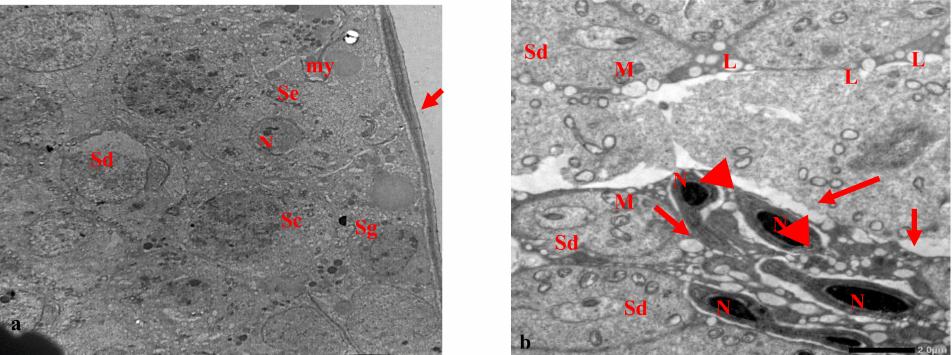
Figure 6. ( a , b ): Electron micrograph of a section of rat’s testis in the control group. ( a ) showing normal seminiferous tubule with normal spermatogenic epithelium (arrow), spermatogonia (Sg), primary spermatocytes (Sc), and spermatids (Sd). Sertoli cell (Se) appeared with the nucleus (N) and the basement membrane enclosing myoid cell (my) ( × 1000). ( b ): showing normal sperms. The sperms have flagellum (head arrow) and an elongated condensed nucleus (N) and an acrosomal cap (arrow). The spermatids appeared (Sd) with the nucleus and cytoplasm rich in mitochondria (M), and lipid droplets (L) between the cells ( ×